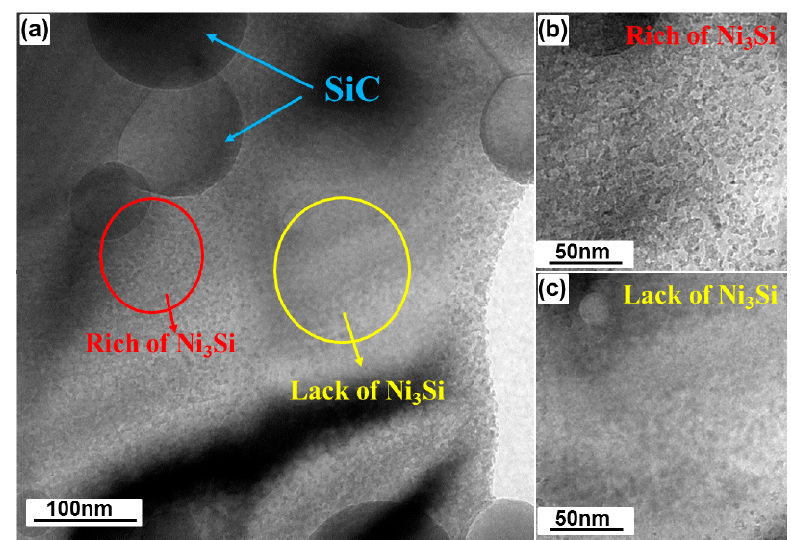
Figure 10. Bright field TEM images of ( a ) SiC and Ni 3 Si distribution, the areas ( b ) rich and ( c ) lack of Ni 3 Si in the matrix of 48-h-milled NiMo-2.5% SiC DPS alloys.